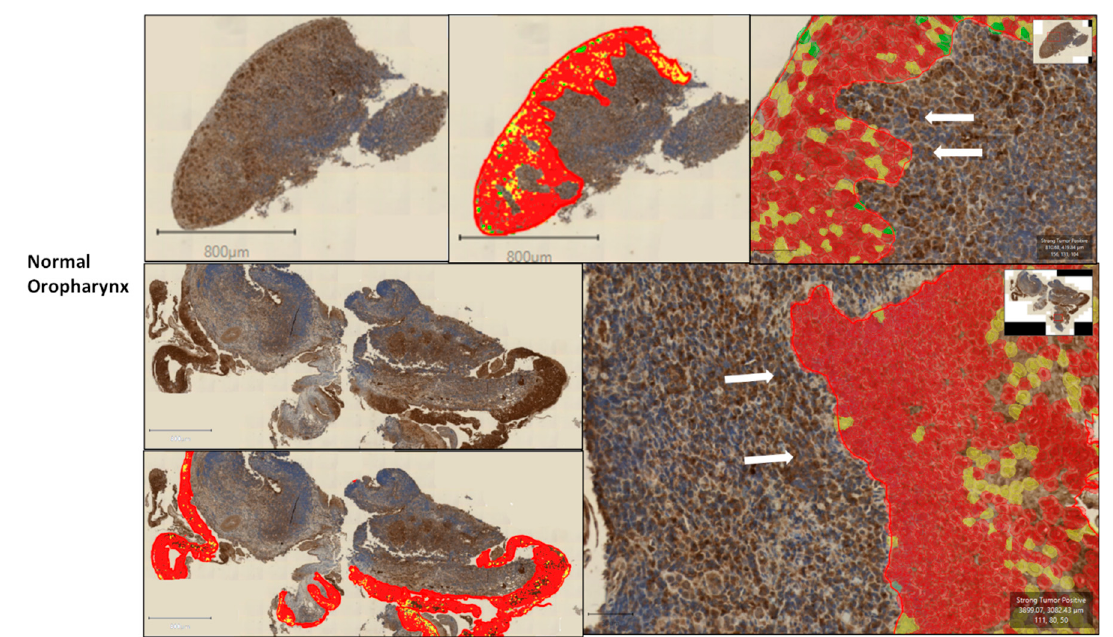
Figure 5. Two examples of normal oropharyngeal epithelia with an underlying heavy inflammatory infiltrate and a loss of the sCTLA-4 staining pattern associated with normal stratification. White arrows point to a subepithelial inflammatory infiltrate. Whole-slide scans (X20); scale bars represent 800 μ m in the whole-section images and 50 μ m in the zoomed-in image. The top panel is a different scene from the same sample in Supplemental Figure S5.